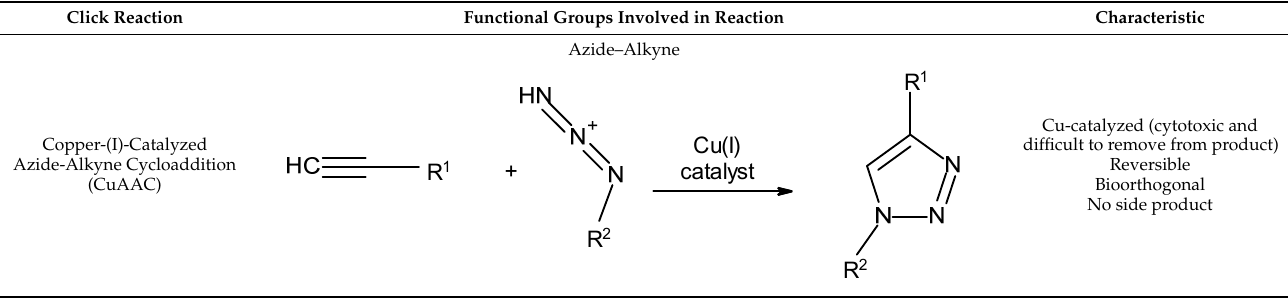
Table 4. Examples of using the click chemistry reaction to obtain new alginate derivatives. Click